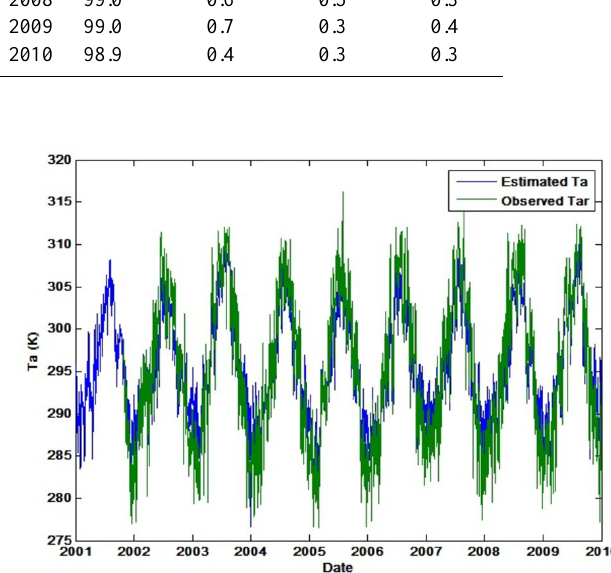
Fig. 6. Daily values of estimated against observed T a at Guardia Sanframondi station